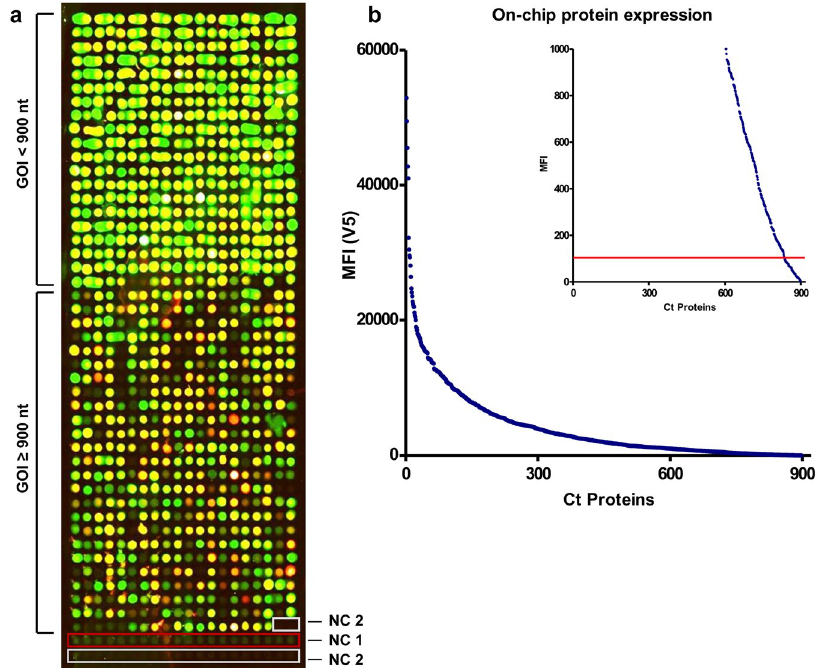
Figure 2. Microarray displaying the whole-proteome of Ct. ( a ) Results of the determination of on-chip protein expression using antibody staining against the terminal tags (green signal: anti-V5 antibody; red signal: anti- His antibody; yellow signal: overlay of both signals). All 898 proteins were spotted onto one array. The last 22 spots indicated by red and white frames represent the negative controls NC1 and NC2, respectively. The upper part of the array comprised genes of interest (GOI) with a DNA template length of up to 900 bp. ( b ) Final MFI values obtained by the anti-V5 antibody were sorted in descending order and plotted against the overall number of Ct proteins. The calculated cut-off (100 MFI) is represented by a red line, indicating that less than 10% of all proteins are below the cut-off and are therefore considered not to be expressed in full